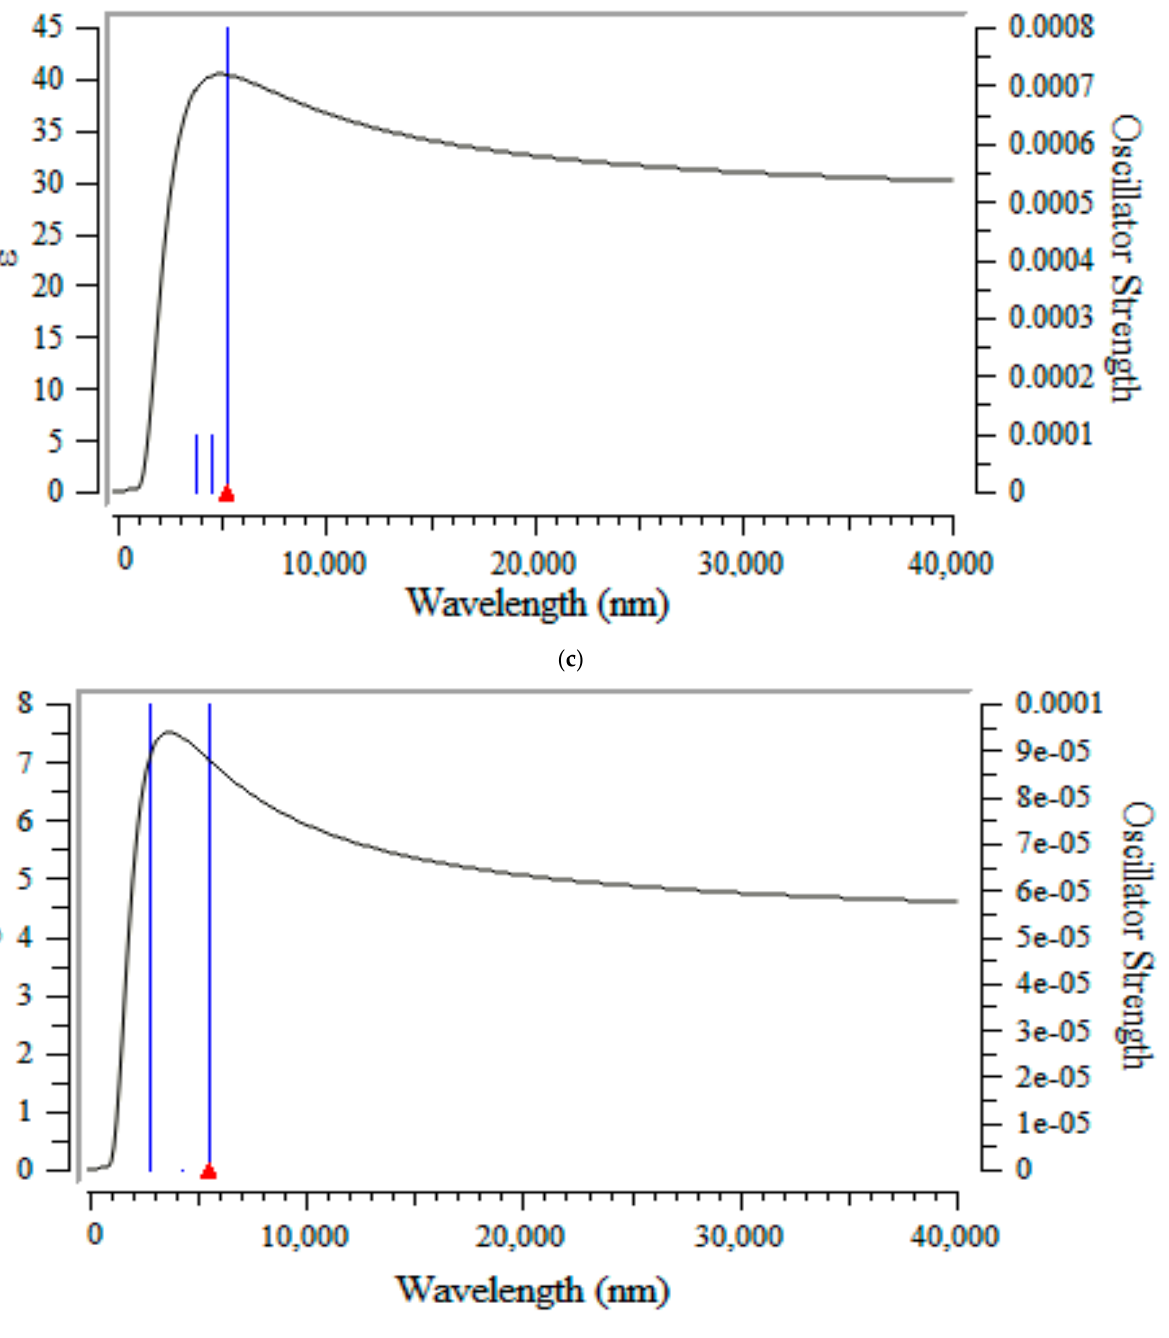
Figure 5. UV-Vis spectra for ( a ) CO → Fe-doped, ( b ) CO → Ni-doped, and ( c ) CO → Zn-doped on the graphene nanosheets. graphene